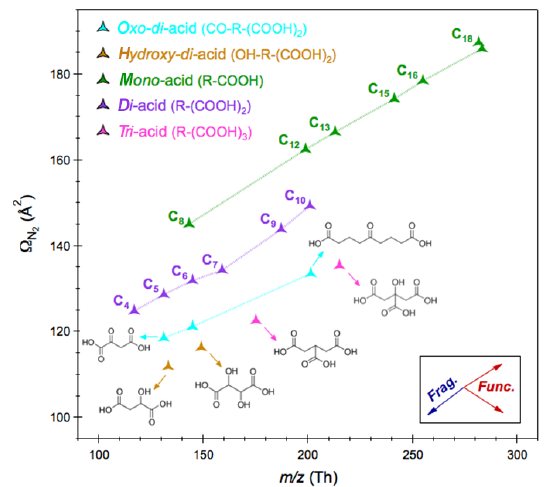
Figure 3. Trajectories associated with reactions involving function- alization (changes in the type and number of functional groups) and fragmentation (changes in the carbon chain length) through the 2-D − m/z space using carboxylic acid series as an (cid:127) N 2